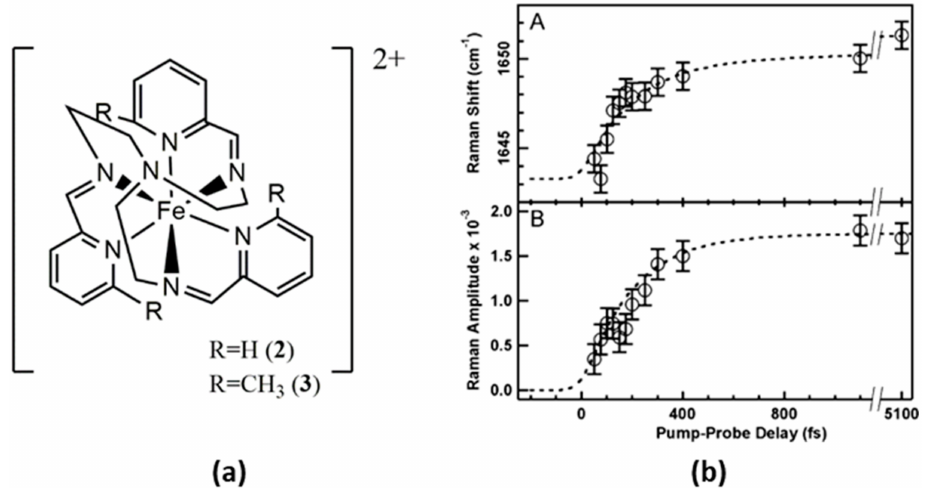
Figure 3. ( a ) Structural drawing of the complex cations [Fe(tren(6-R-py) 3 )] 2+ (R = H ( 2 ), CH 3 ( 3 )). Complex 2 is a poorly LS complex, while complex 3 is poorly HS. ( b ) Time dependence of the energy change (A) and spectral amplitude (C=N stretching vibration of [Fe(tren(py) 3 )](PF 6 ) 2 ) based on the femtosecond stimulated Raman data (B). ( b ) is reprinted with permission from ref. [72], copyright 2008, American Chemical